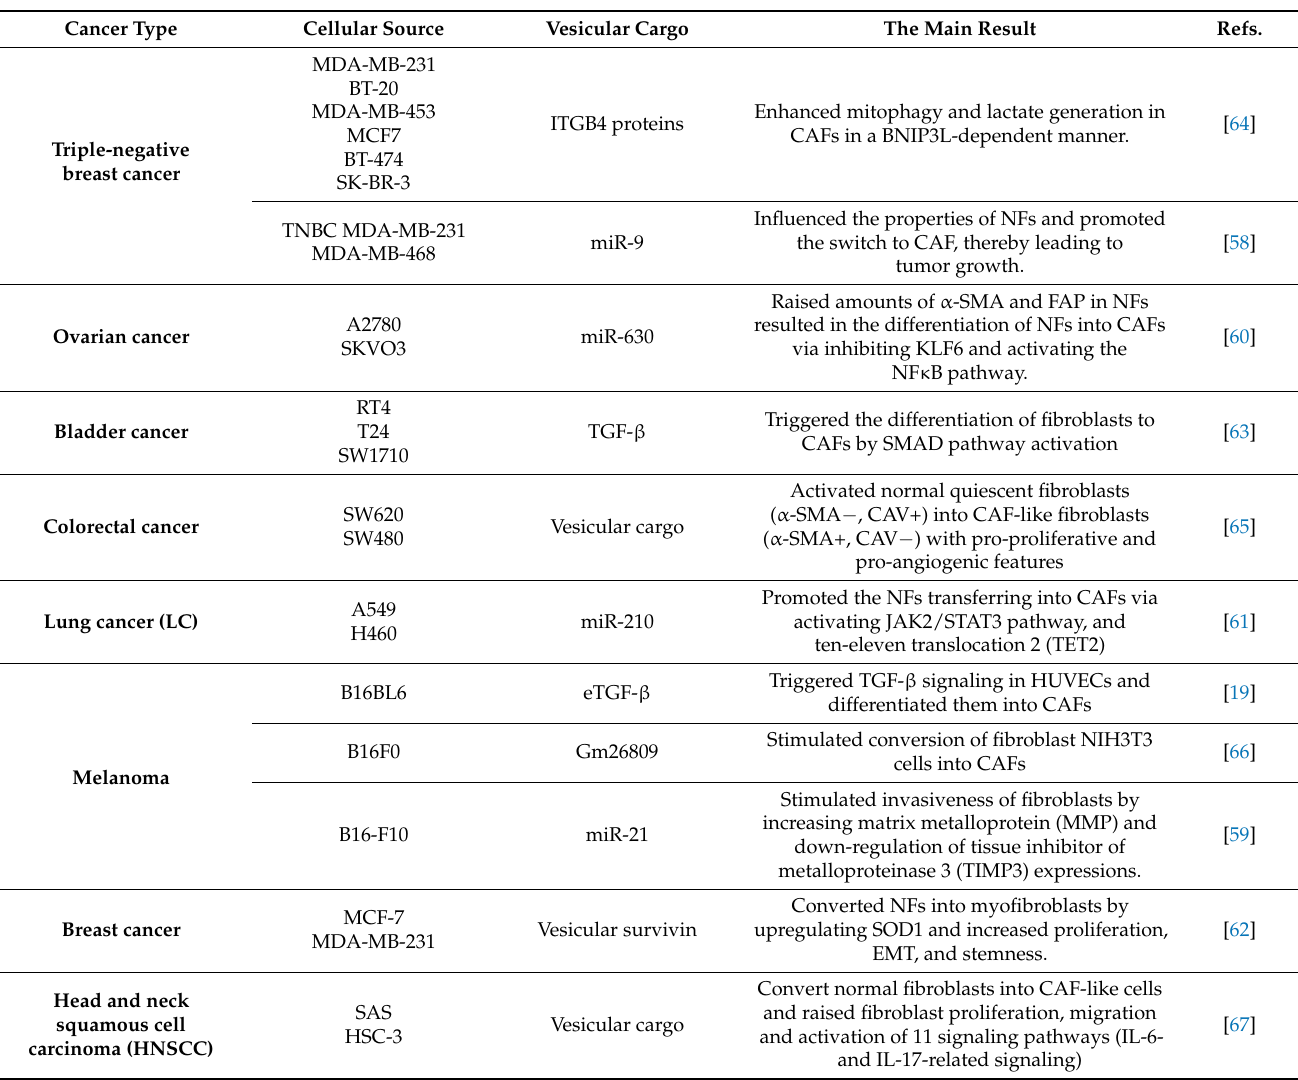
Table 2. Effect of tumor-derived extracellular vesicles on fibroblast differentiation in the tumor